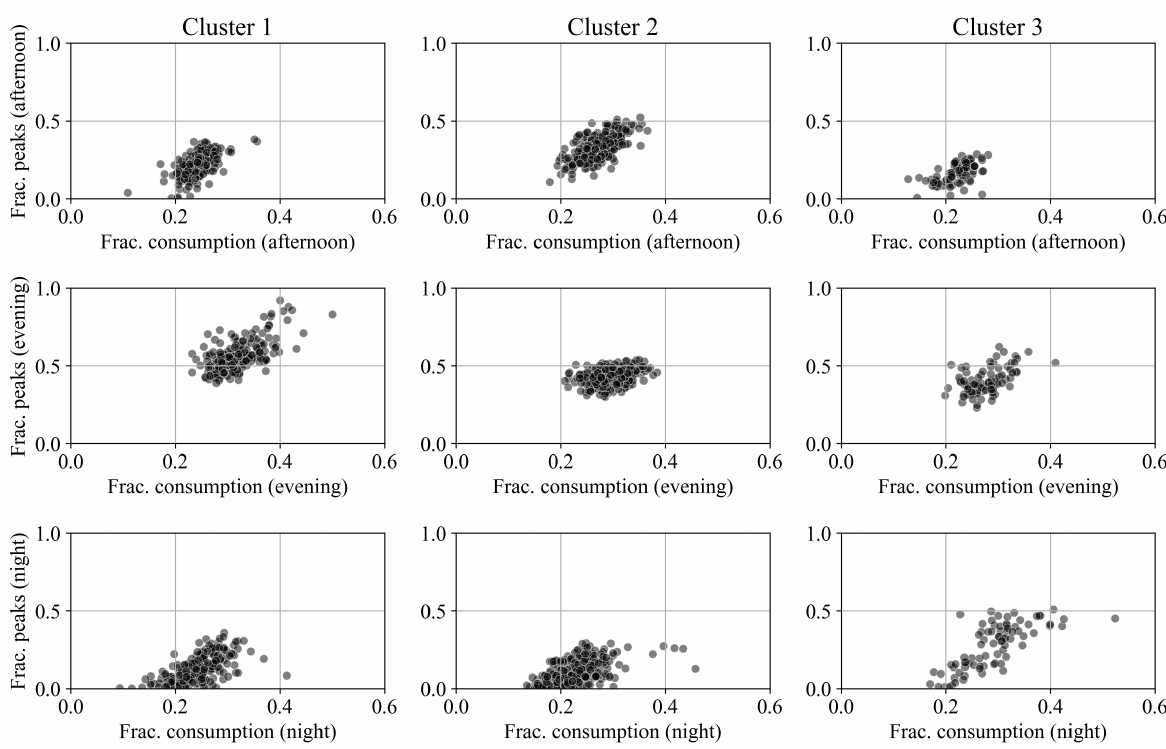
Figure 16. Relation between the fraction of consumption and peak demands in three time periods at the daily level for clusters